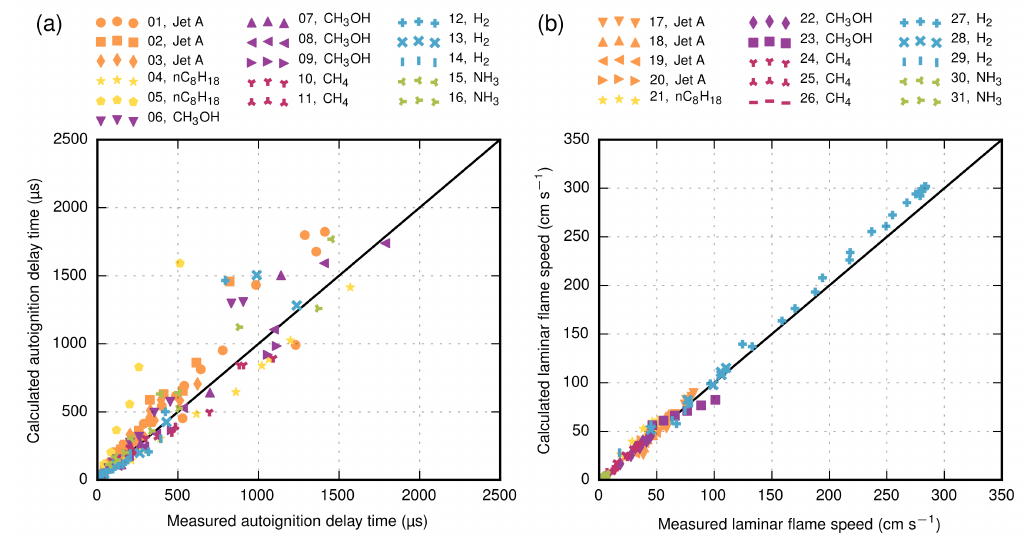
Figure 4. Comparison of calculated and experimental data [58,61–78]: ( a ) Autoignition delay time; ( b ) Laminar flame speed.